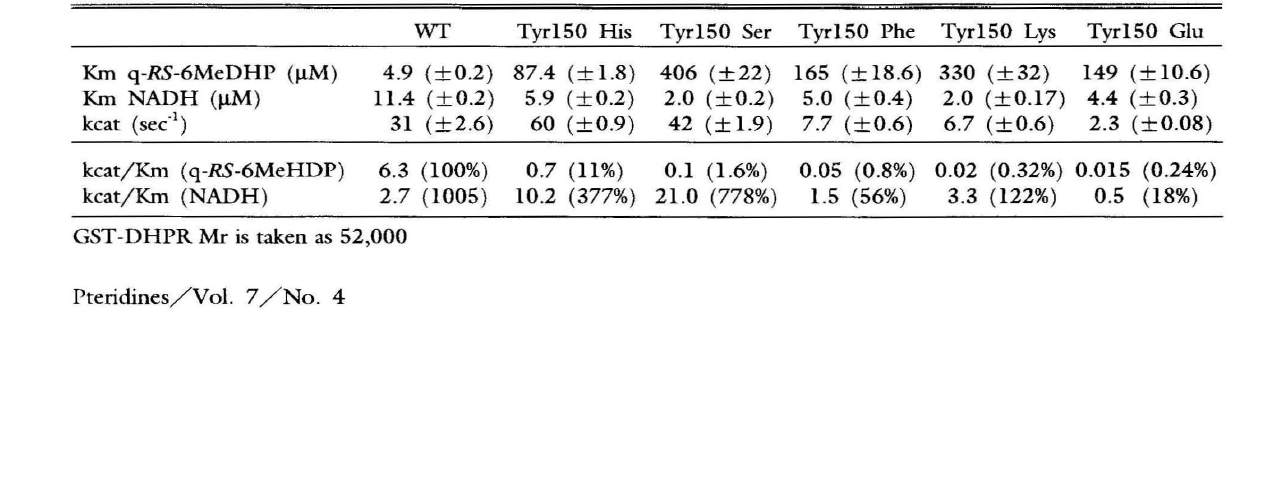
Figure 4. kcat/Km values of DHPR mutants at residue ISO (WT has TyrlS0, the second substrated is in brackets). Table 3. Kinetic paramenters of mutated GST-DHPR* fusion proteins. 0.1 M Tris-HCI buffer (pH 7.4) at